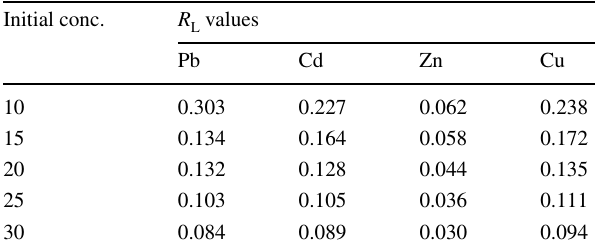
are determined by plotting ln C e against ln q e as shown in Fig. 11. The Langmuir isotherm showed better fit to the experi- mental data with higher correlation coefficients for all the metal ions; as given in Table 2, the maximum adsorption capacities of the adsorbent were found to be between 8.68 and 7.17 mg/g. The R L in the range of 0–1 decreased with increasing initial metal ion concentration which indicates favourable uptake of metal ions.